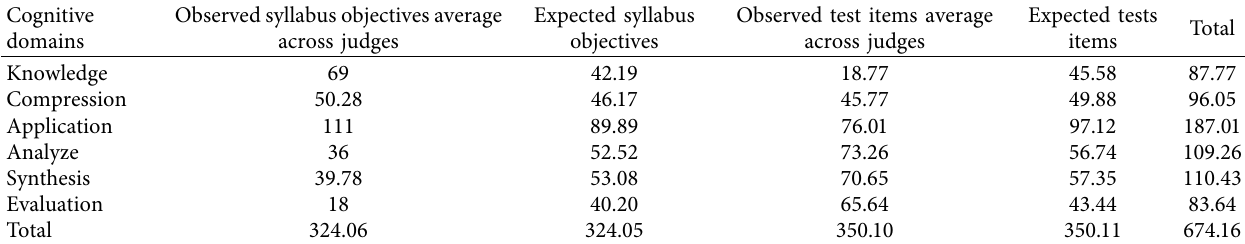
Table 8: Number of observed and expected tests items from the syllabus cognitive domain subcategories. Cognitive